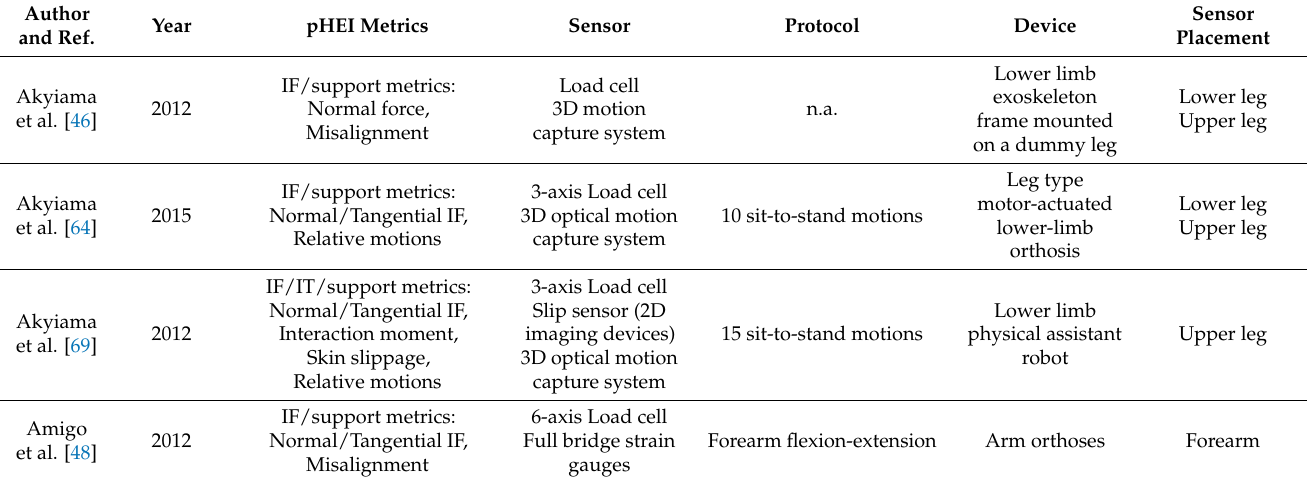
Table 2. Review summary. IF: interaction force, IT: interaction torque, IP: interaction pressure, n.a.: not